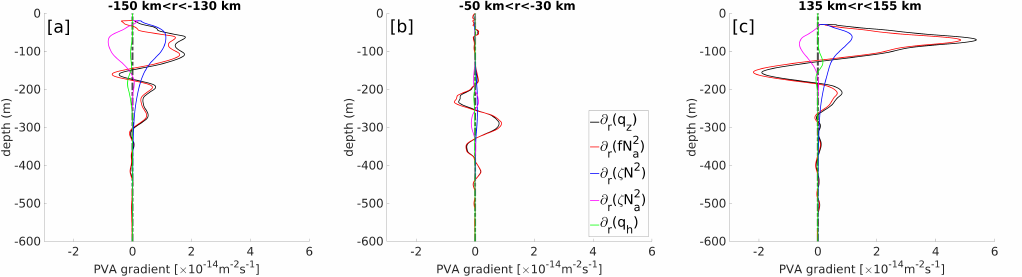
Figure 16. Same as Figure 14 for the radial gradient of the vertical component of Ertel’s potential vorticity anomaly. (panel ( a ): − 150 km < | r | < − 130 km; panel ( b ): − 50 km < | r | < − 30 km; panel ( c ): 135 km < | r | < 155